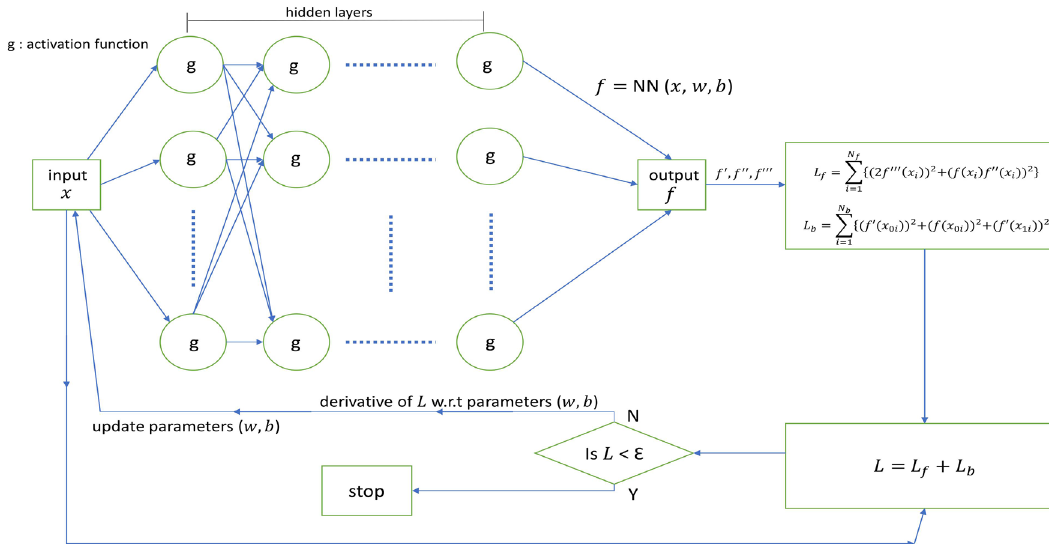
Figure 3. Schematic representation of PINN for Blasius viscous flow